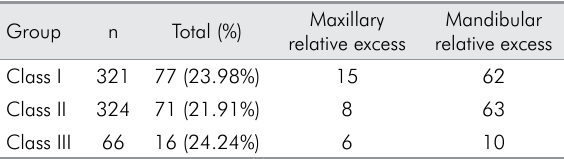
Table 6. Frequency of patients presenting anterior Bolton discrepancy greater or smaller than 2 SD (< 73.9 or > 80.5).